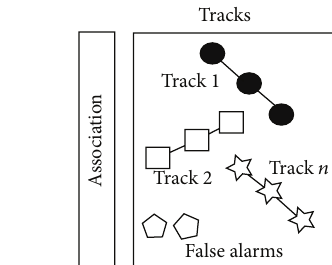
Figure 5: Conceptual overview of the data association process from multiple sensors and multiple targets. It is necessary to establish the set of observations over time from the same object that forms a